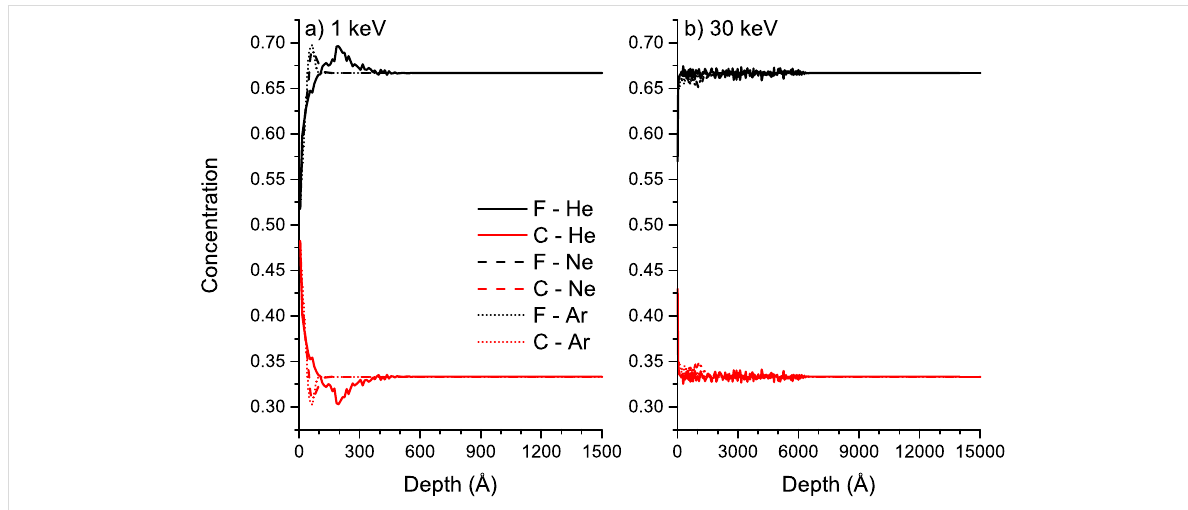
Figure 12: Concentration profiles of F and C at a fluence of 10 18 ions/cm 2 for He, Ne and Ar bombardment of PTFE: a) for 1 keV, and b) 30 keV impact energy. The results have been obtained by SD_TRIM_SP.